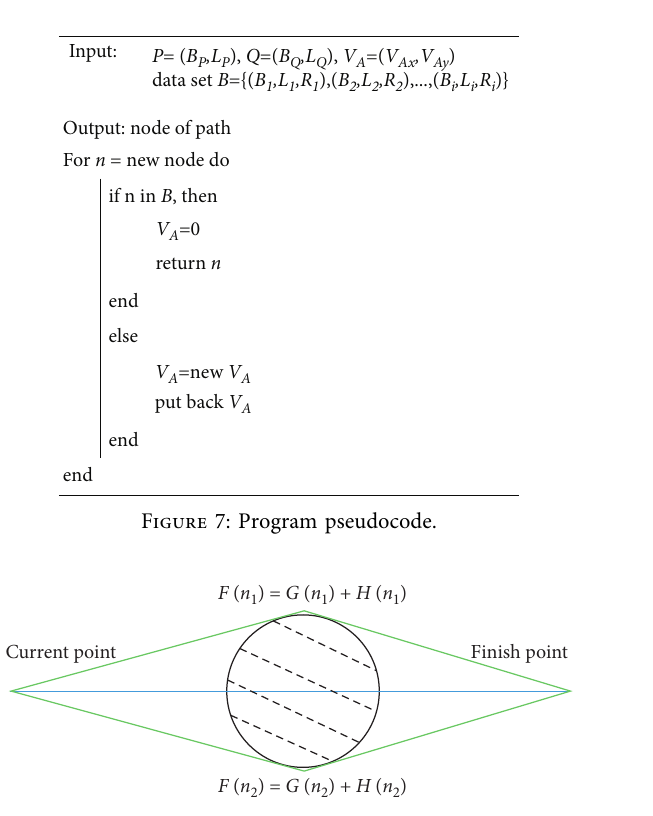
Figure 8: Searching process by the improved A-star algorithm.